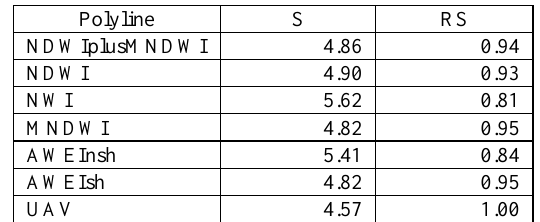
Table 2. Sinuosity (S) and relative sinuosity (RS) per polyline (epoch: